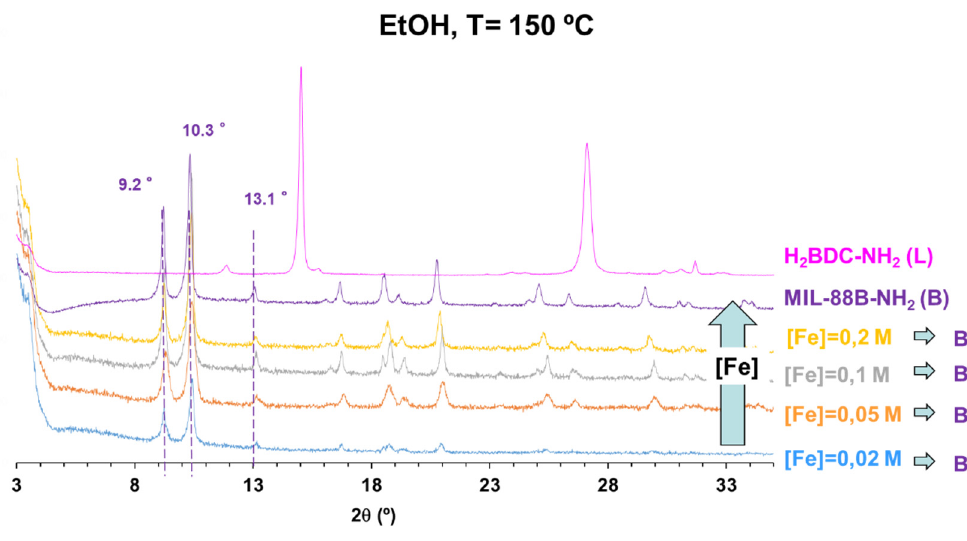
Figure 4. PXRD patterns for the MW investigation of the system FeCl 3 · 6 H 2 O / H 2 BDC-NH 2 in ethanol (V EtOH = 4 mL, T = 150 ° C, t = 5 min) after activation with EtOH, compared to simulated MIL-88B-NH 2 (purple) and H 2 BDC-NH 2 (pink).